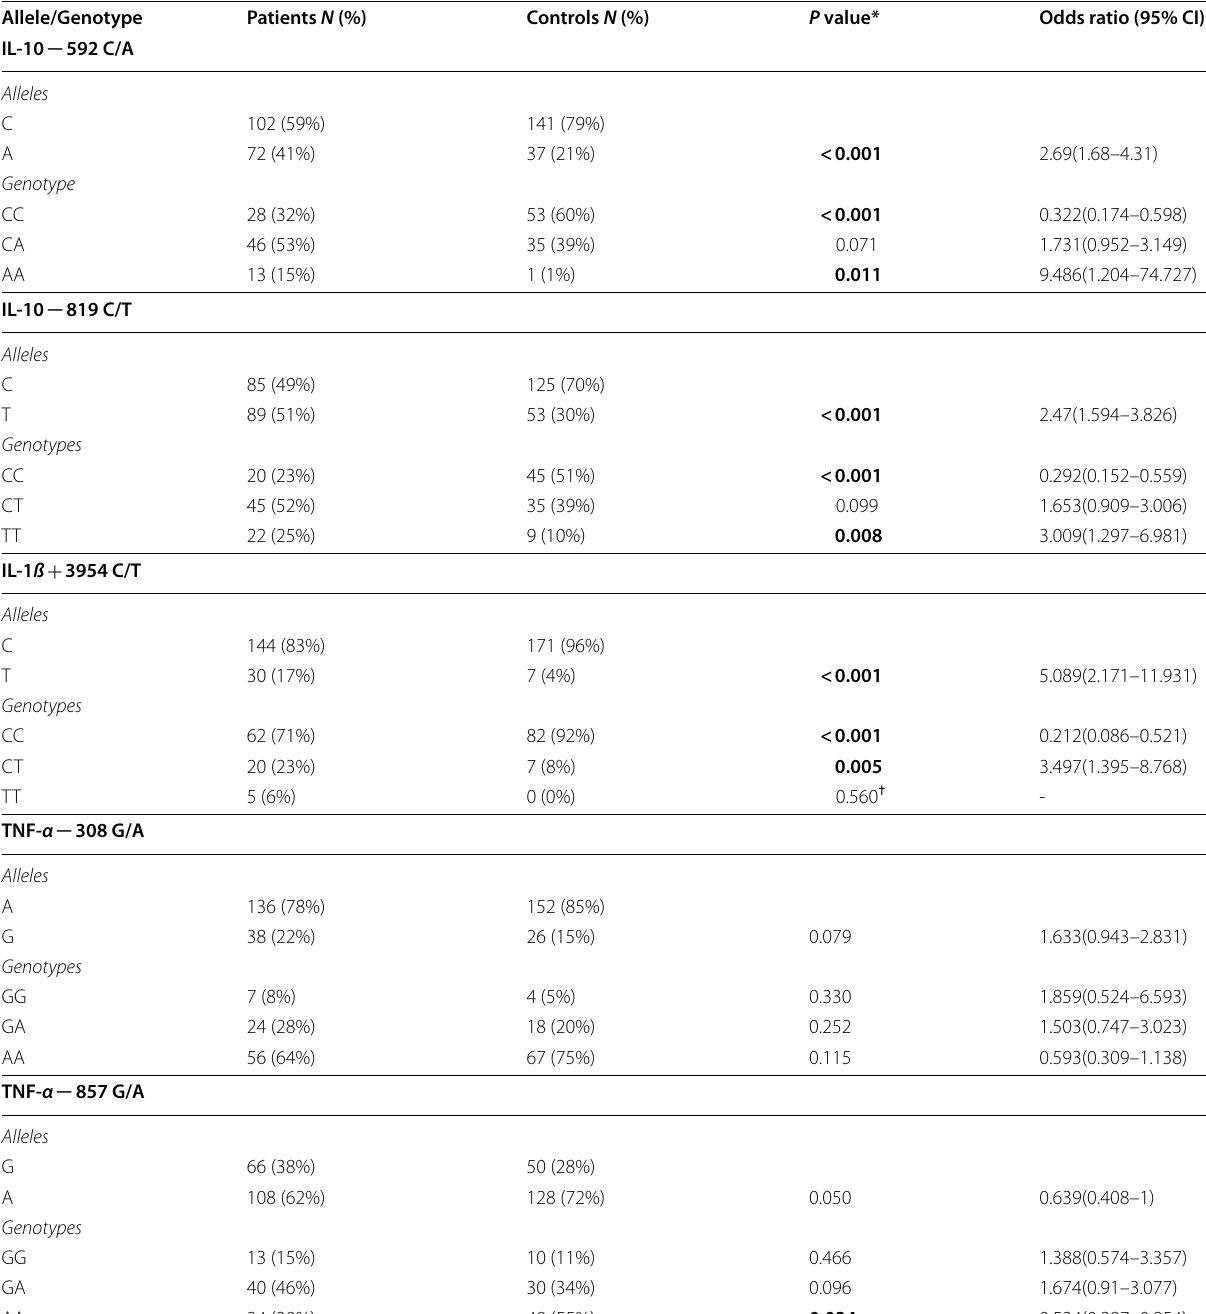
Table 3 Association of IL-10, IL-1 ß , and TNF- α polymorphisms with risk of